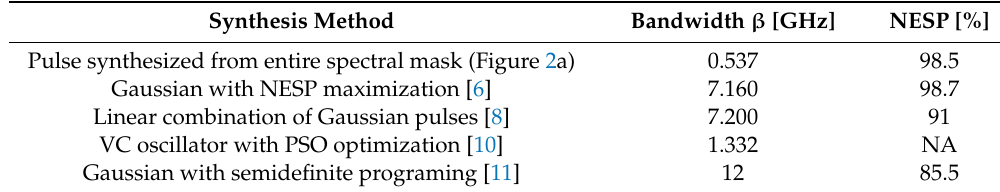
Table 3. UWB pulse parameters.